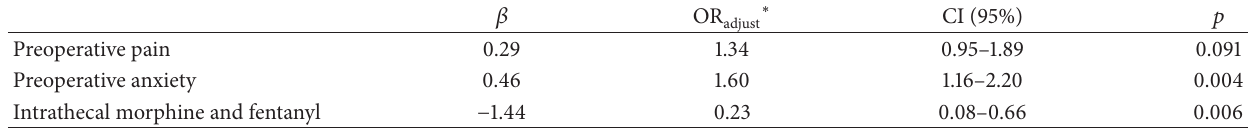
Table 4: Multivariate analysis of moderate-severe postoperative pain